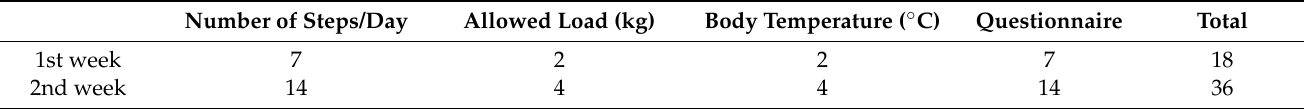
Table 2. Number of measurements requested from each patient in the second